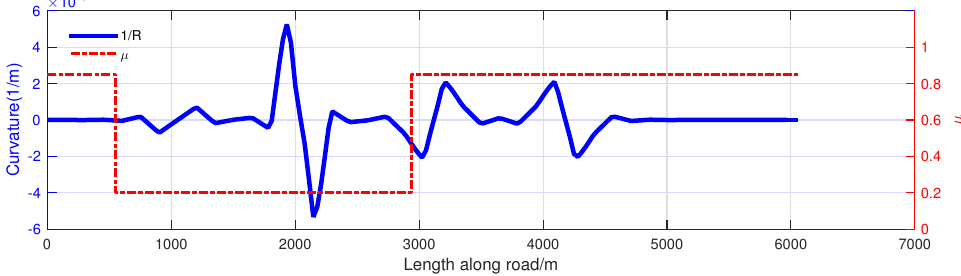
Figure 21. Curvature and friction coefficient of the road.